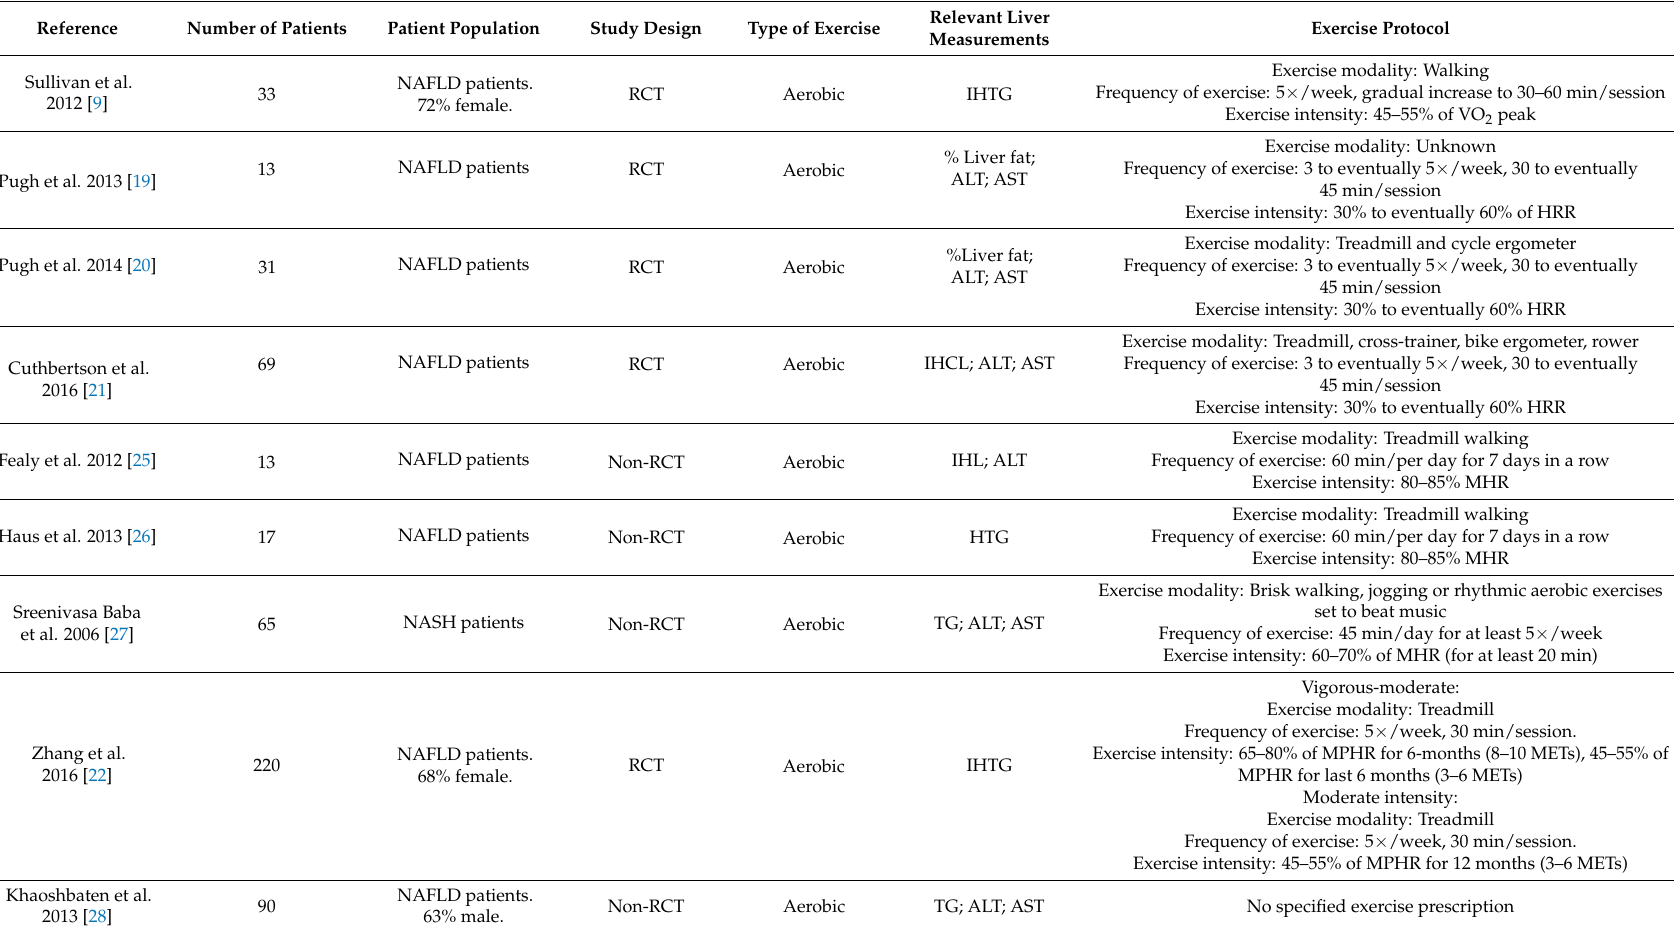
Table 1. Published Exercise Interventions in Nonalcoholic Fatty Liver Disease